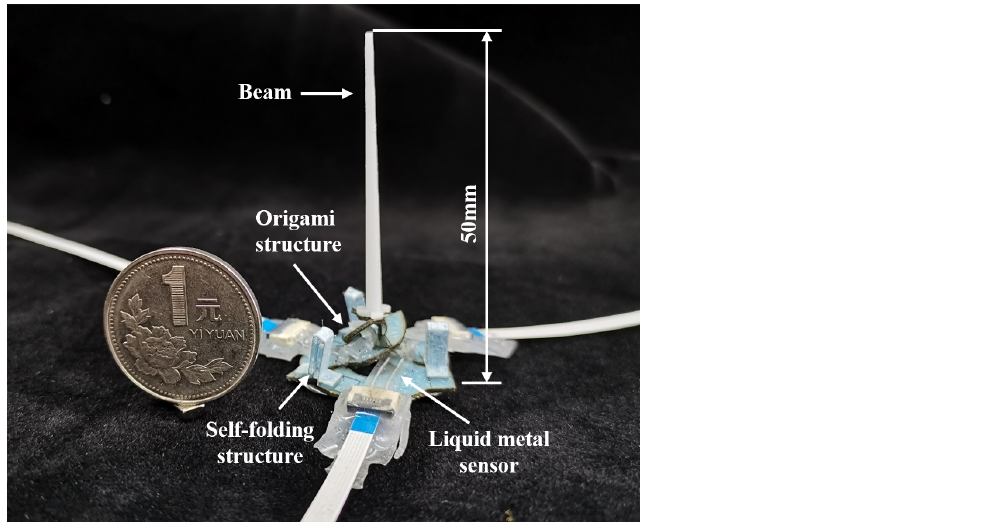
Figure 1. A miniature soft sensor with origami-inspired self-folding parallel mechanism. The coin’s diameter is 25